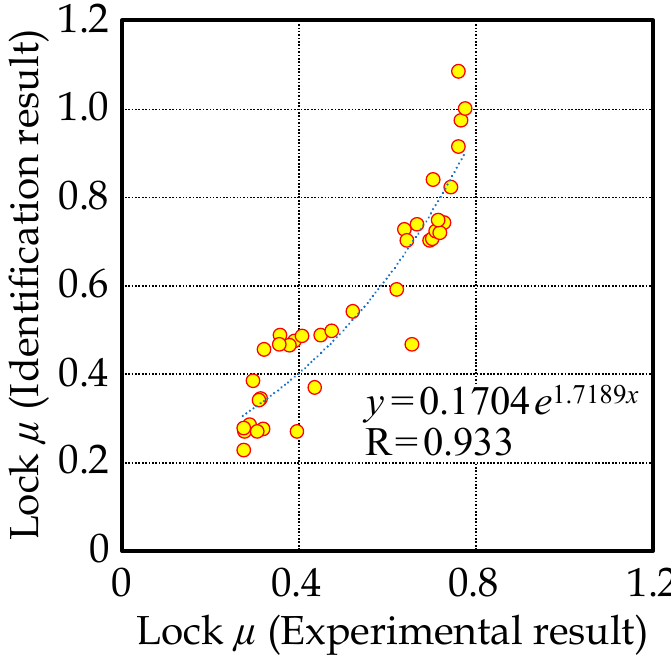
Figure 4. Comparison between experimental results and identification results at lock µ . From Figure 4, the lock µ obtained from the experiment and that from Equation (2) have strong non-linearity, and the value from Equation (2) is smaller in the low µ region. Therefore, when obtaining the µ -s characteristics widely, it is preferable to include an estimated value of lock µ for identification. Peak µ in these low µ regions occurs at relatively low slip ratios. Past studies show that the reduction in lock µ is relatively large relative to the peak µ that occurs at such low slip ratios. Therefore, we added data on wet roads where the peak µ appears in a region with a low slip ratio, focused on the relationship between the slip ratio and the ratio of lock µ by peak µ , and the obtained results are shown in Figure 5. A logarithmic approximation of this relationship is shown in Figure 5, but since these correlation coefficients are relatively high at about 0.81, the peak µ obtained from the analysis of Equation (2) using the three-set data obtained from the experiment is used to estimate lock µ [19]. Therefore, the identification method using Equation (2) with three points that has been performed so far is modified and a new identification method of Equation (2) is performed using four points including the obtained lock µ . Identification is performed using such an algorithm and Figure 6 shows the peak µ and lock µ values obtained by this modified identification method compared with the results in Figure 1. Generally, in µ -s characteristics measurement, to avoid uneven tire wear, measurement up to locking is not performed. Therefore, the µ -s characteristics in Figure 1 do not show up to a slip ratio of 1. We must use an estimate of the experimental lock µ using the trend from the peak µ to the maximum measured slip ratio. From these results, the correlation coefficients in both figures show high values (0.961 and 0.819) and the µ -s characteristics are well expressed using the modified method. Using this method, it is possible to modify the entire µ -s characteristic including the lock µ with relatively high expression while identifying the peak µ value